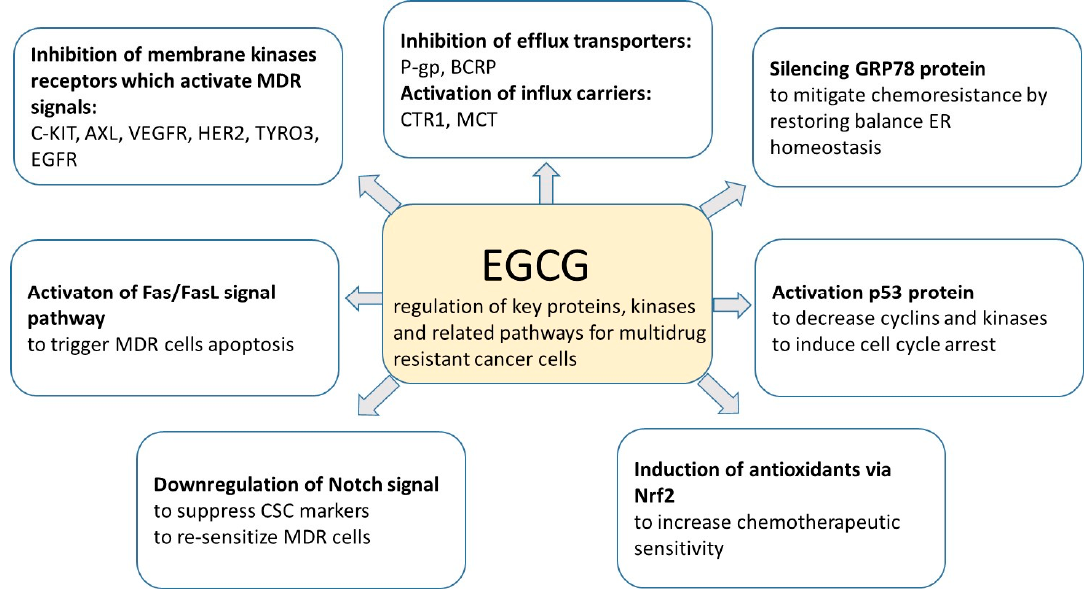
Figure 6. Mechanism of multidrug resistance (MDR) inhibition by epigallocatechin gallate (EGCG) (based on [85]).